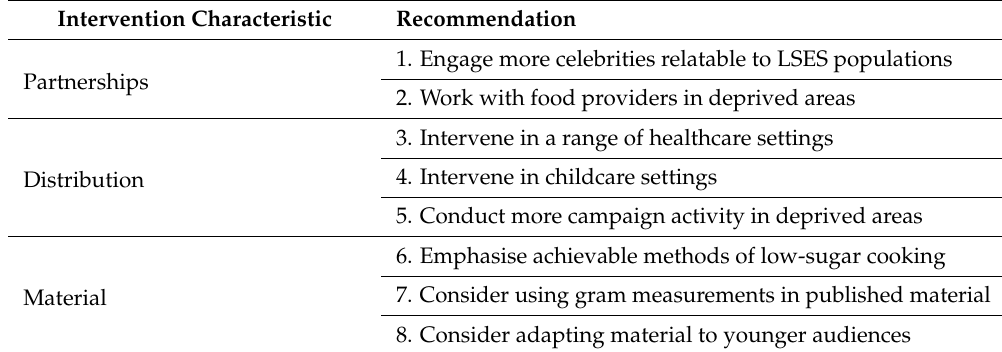
Table 2. Recommendations for information-based sugar reduction